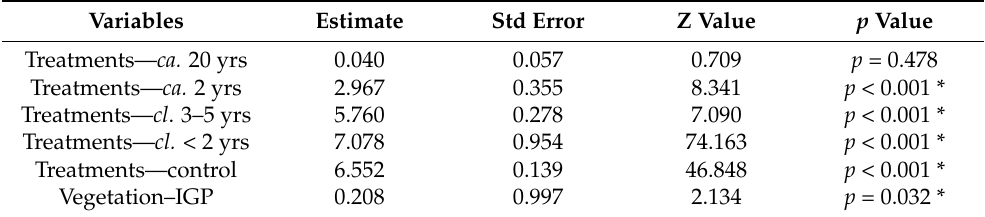
Table 4. The output of a generalized linear mixed model fitted by a maximum likelihood (Laplace Approximation) showing treatment types and vegetation type. Significant values are indicated by an